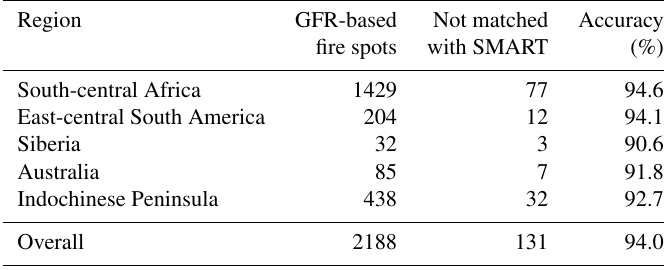
Table 4. Accuracy assessment of FY-3D-identified fires based on SMART (visual